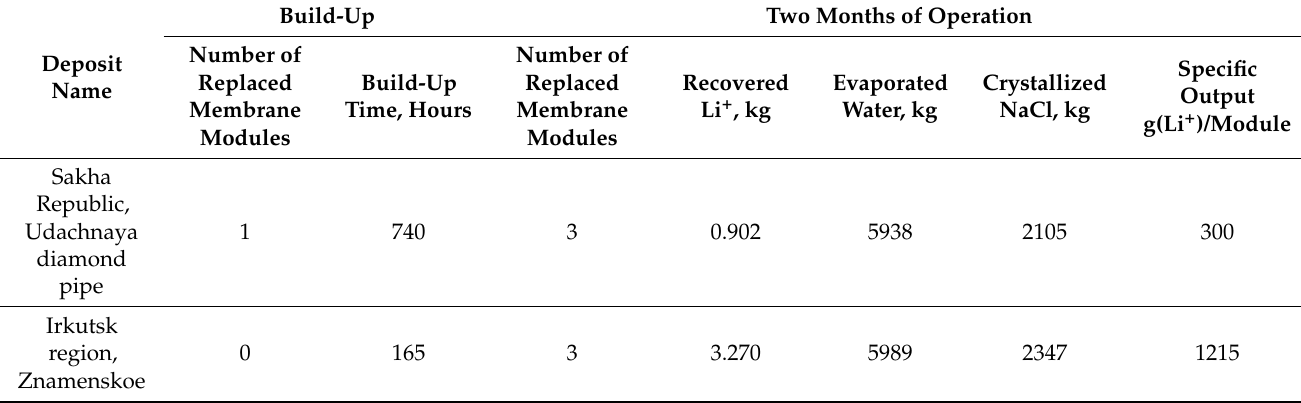
Table 10. Results for various deposits. Simulation conditions: T f = 60 ◦ C, Rt = 20 h, RR = 97%, S = 2.5 m 2 , C Li+ = 2.3 g/kg, MPT = 50%, ER(Li + ) =